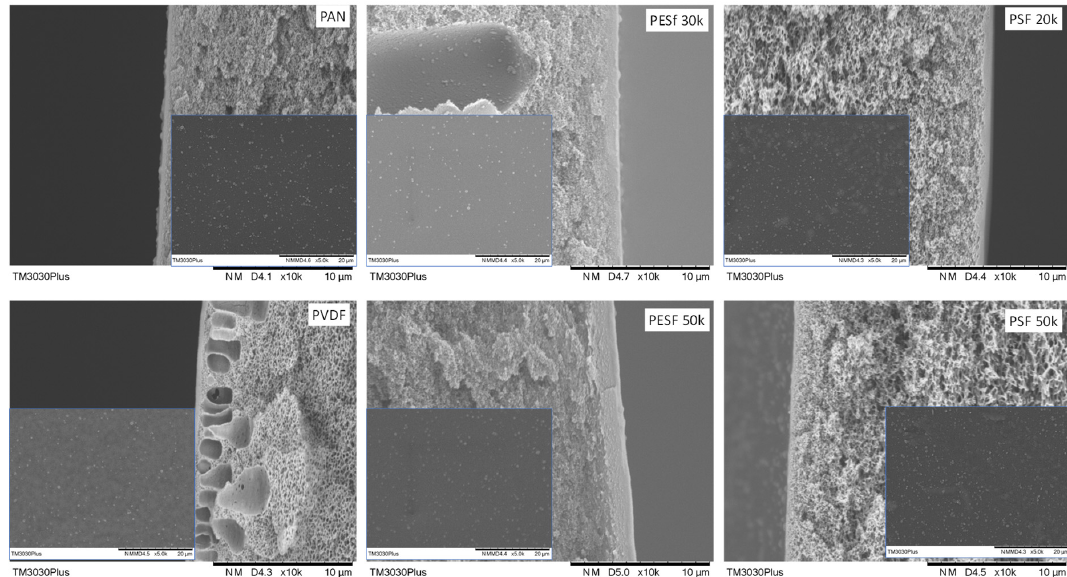
Figure 8. Stability performances of Pebax membrane in the dry state (1 wt.%), 0% RH, feed pressure of 2 bar at 35 °C.